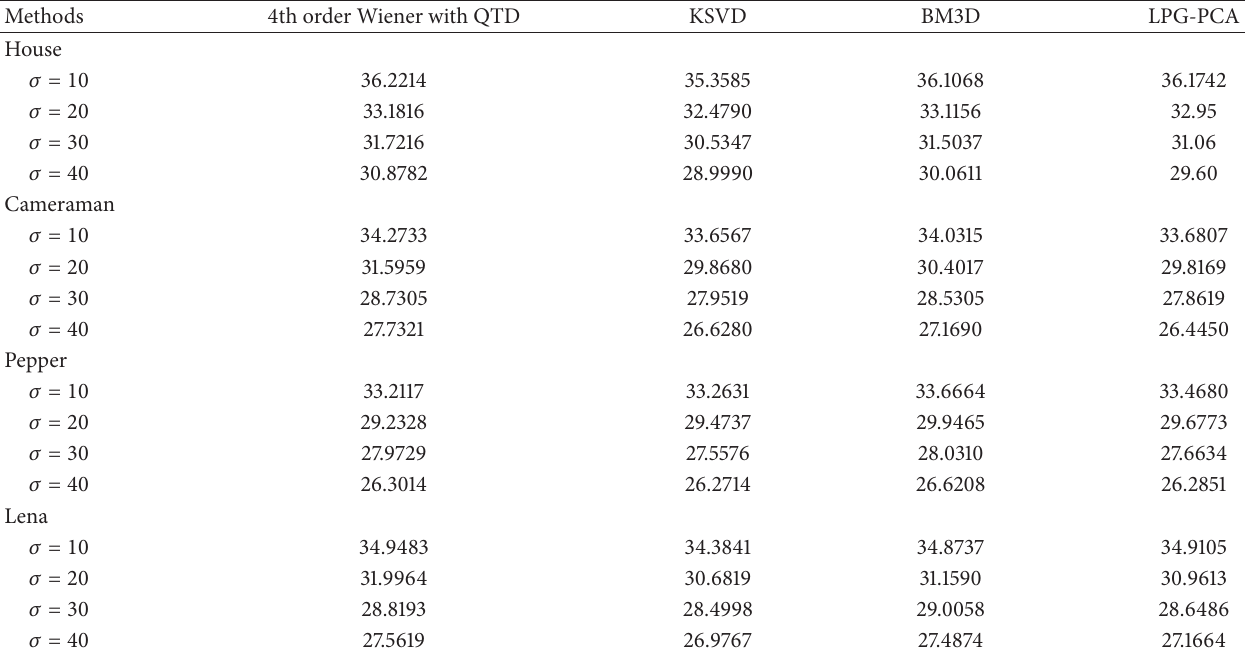
Table 1: Comparison between the 4 h order Wiener and other